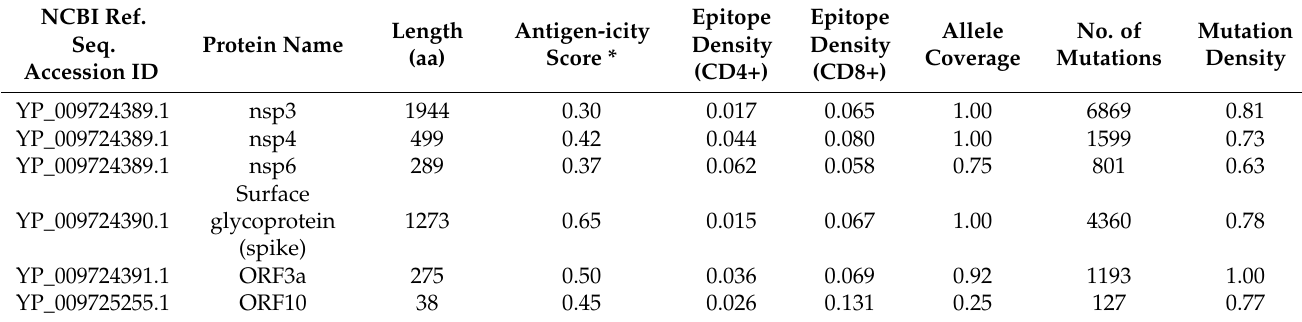
Table 2. T-cell antigens of SARS-CoV-2 and their corresponding antigenicity scores * , epitope density, allele coverage, number of mutations, and mutation density. NCBI Ref.